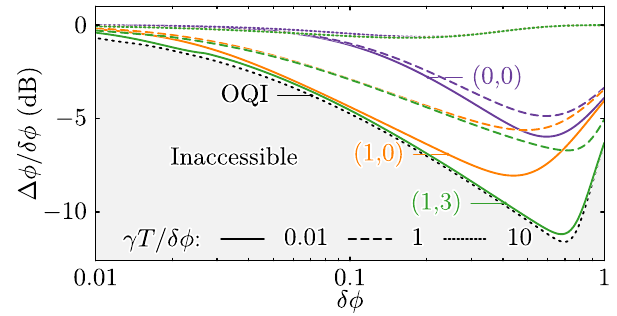
FIG. 6. Accuracy of an optimized N ¼ 64 particle interferom- eter in the presence of single-particle dephasing noise exposures γ T= δϕ relative to the prior distribution width, indicated by different line styles. The results are displayed for different circuit ; n n complexities ð n with 3 ð n variational parameters. en de Þ en þ de Þ For comparison the accuracy of the noise free optimal quantum interferometer (OQI) is indicated by the black dotted